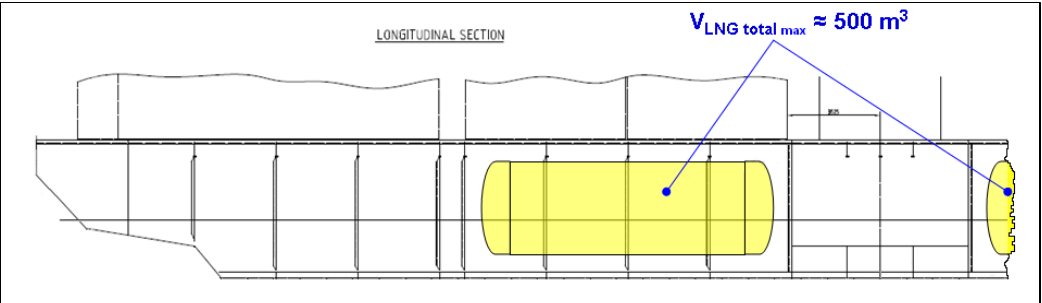
Source: PORT FEEDER BARGE, Hamburg